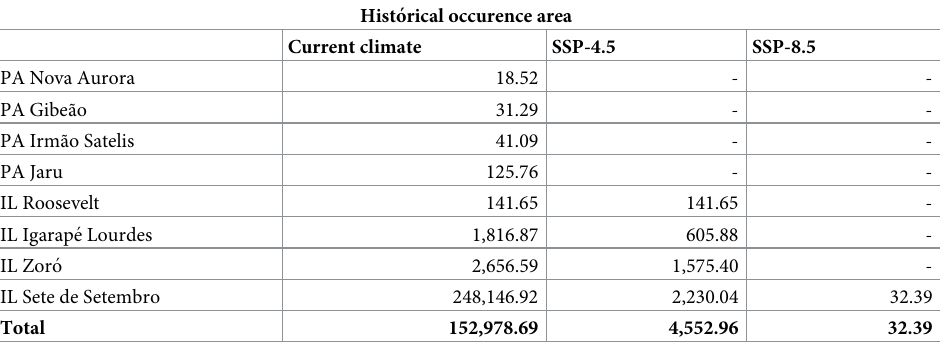
Table 1. Protected areas (PAs) and indigenous lands (ILs) with AES for M . nigriceps in current climate scenario, and under the scenarios SSP2-4.5 and SSP5-8.5 (expressed as km 2